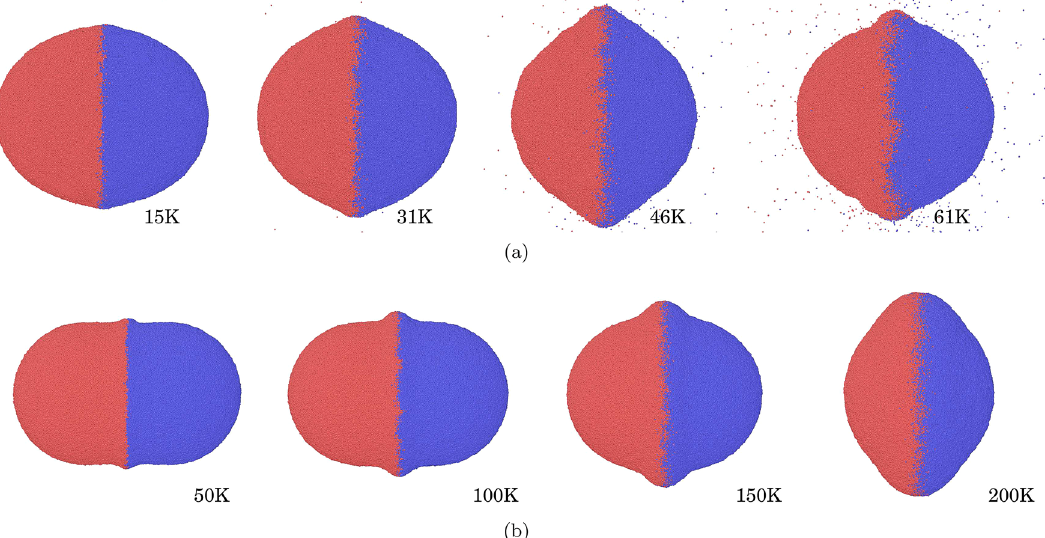
Figure 1. Configuration of the merged cluster for ( a ) Ar and ( b ) water NP collisions at the end of the simulation for the initial temperatures T 0 indicated. Color denotes initial NP affiliation. The snapshots in each row are at the same